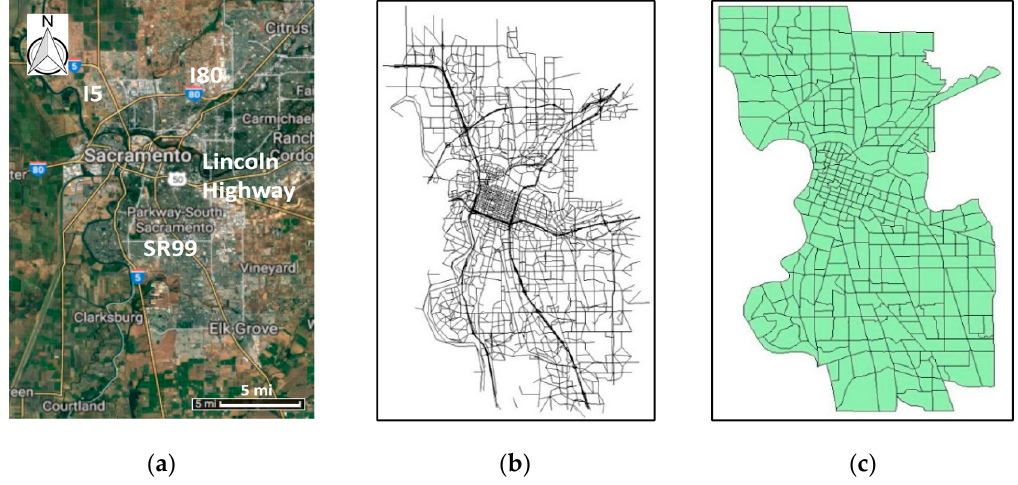
Figure 2. Sacramento study area. ( a ) Case study domain (source: Google Map), ( b ) Roadway network in Baseline 2012, ( c ) traffic analysis zones (TAZs).